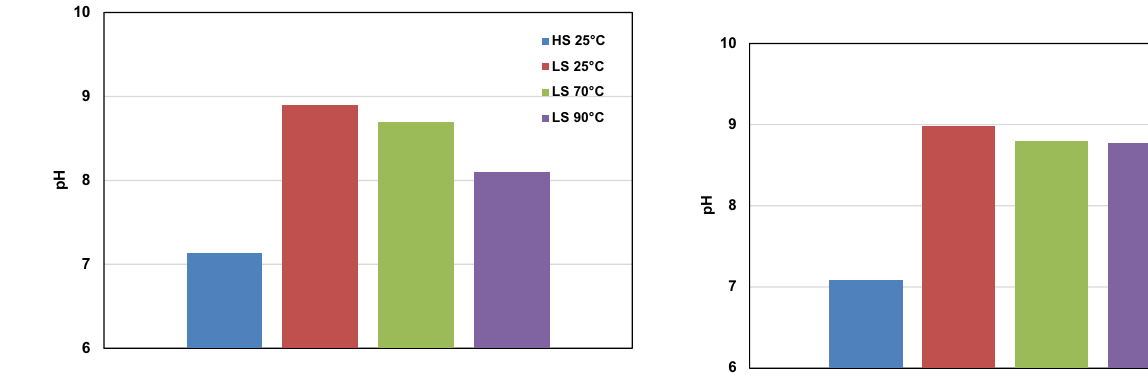
Fig. 5 Effluent pH profile at 25, 70, and 90 °C for